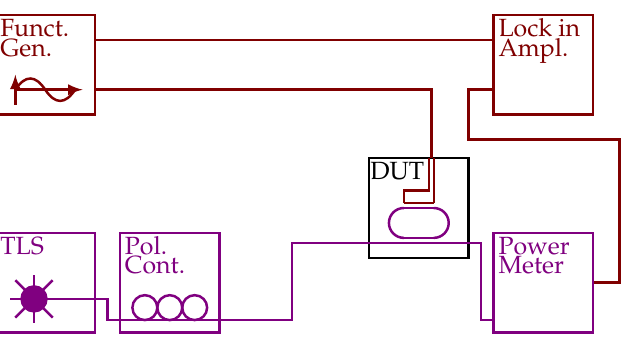
Figure 4. Experimental setup used for the measurement of the resonance wavelengths of a ring resonator. Using single mode fibers and grating couplers, light from a TLS was coupled into an access waveguide and out to a power meter. A function generator supplying a sinusoidal signal and a lock-in amplifier locked to the double frequency of the sinusoidal were used to extract the signal of a single ring resonator. The SOI chip with the ring resonator is labeled device under test (DUT); optical connections are indicated in purple and electrical connections in